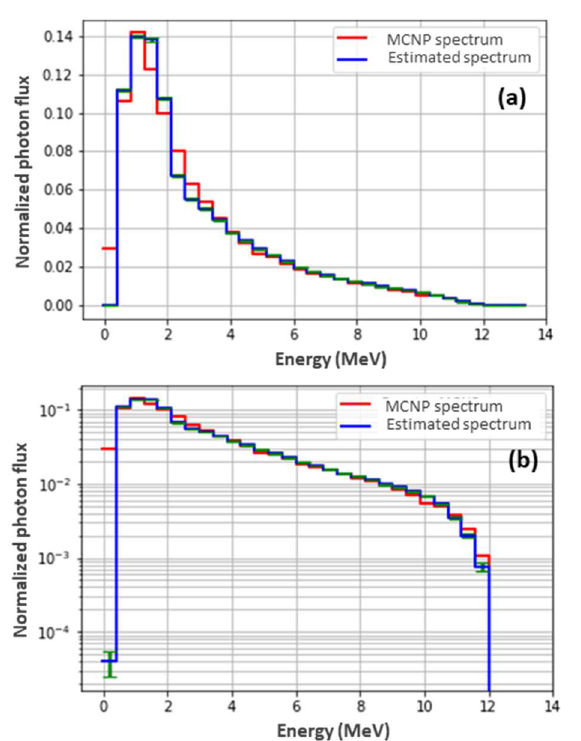
Fig. 6. (a): Transmission curve from modelling (red dots) and transmission curve from the estimated spectrum (blue) - (b): Relative differences between the two transmission curves as a function of energy.